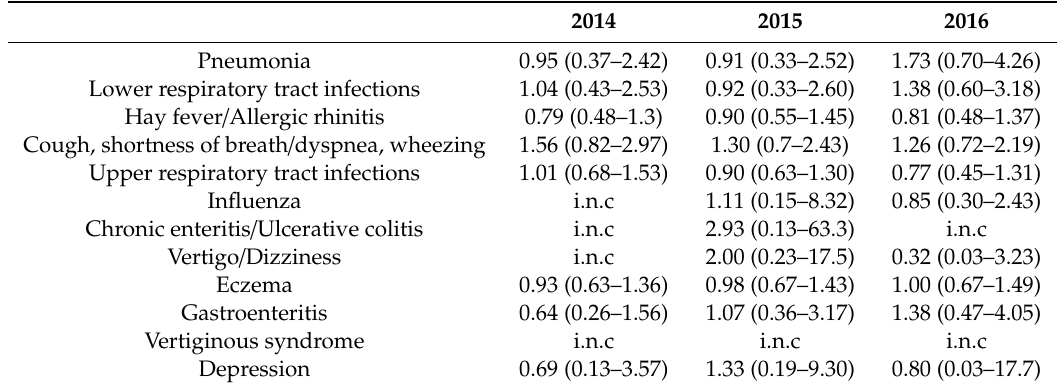
Table A10. Di ff erences (OR, 99% CI) a per year in various comorbid conditions between livestock dense areas and control areas among children with asthma b .